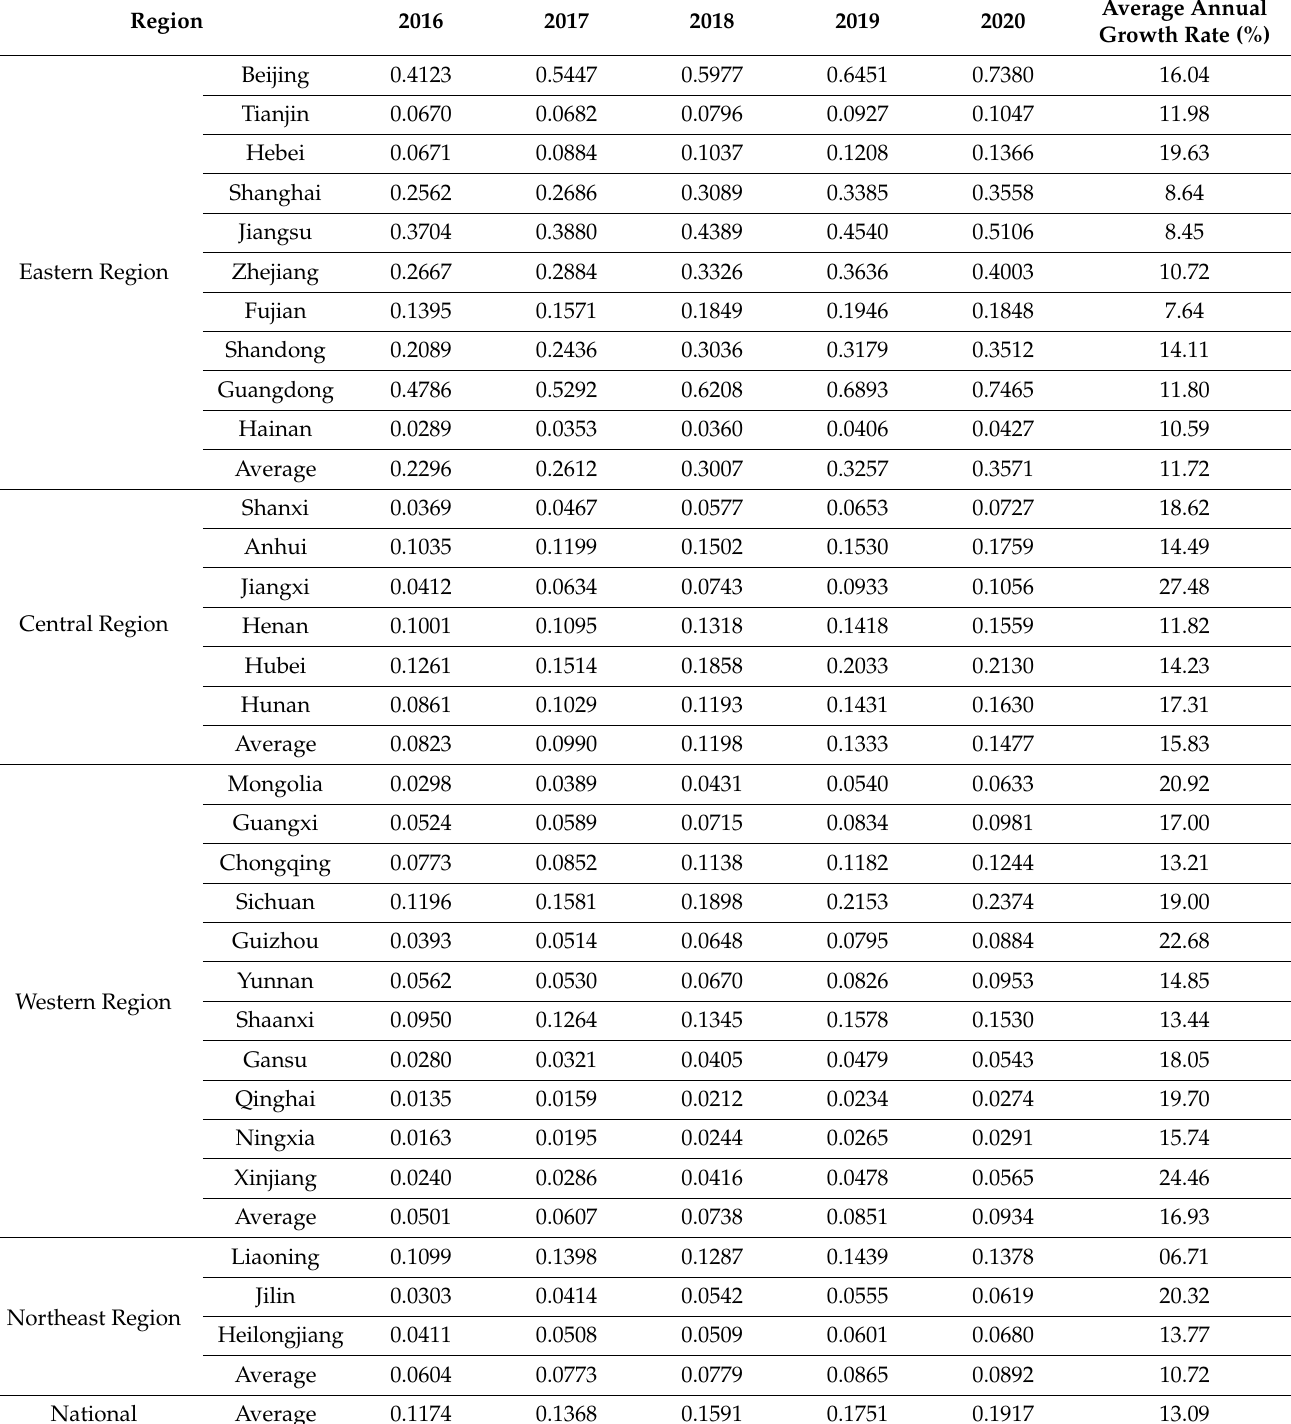
Table 2. Results of measuring the development level of the digital